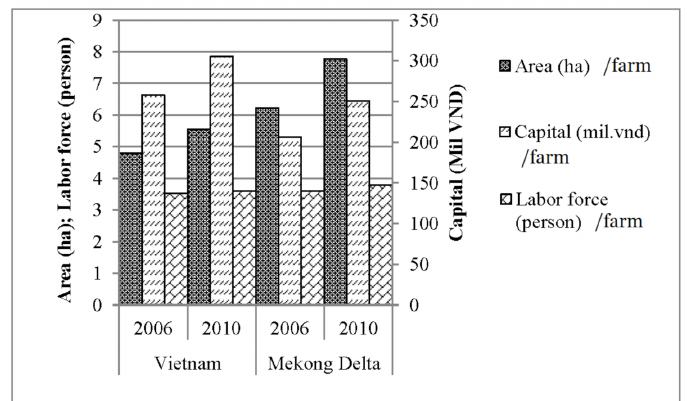
Figure 6. Characteristics of a large farm in all of Vietnam and the Mekong Delta in 2006 and 2010; Source: created from GSO 2013